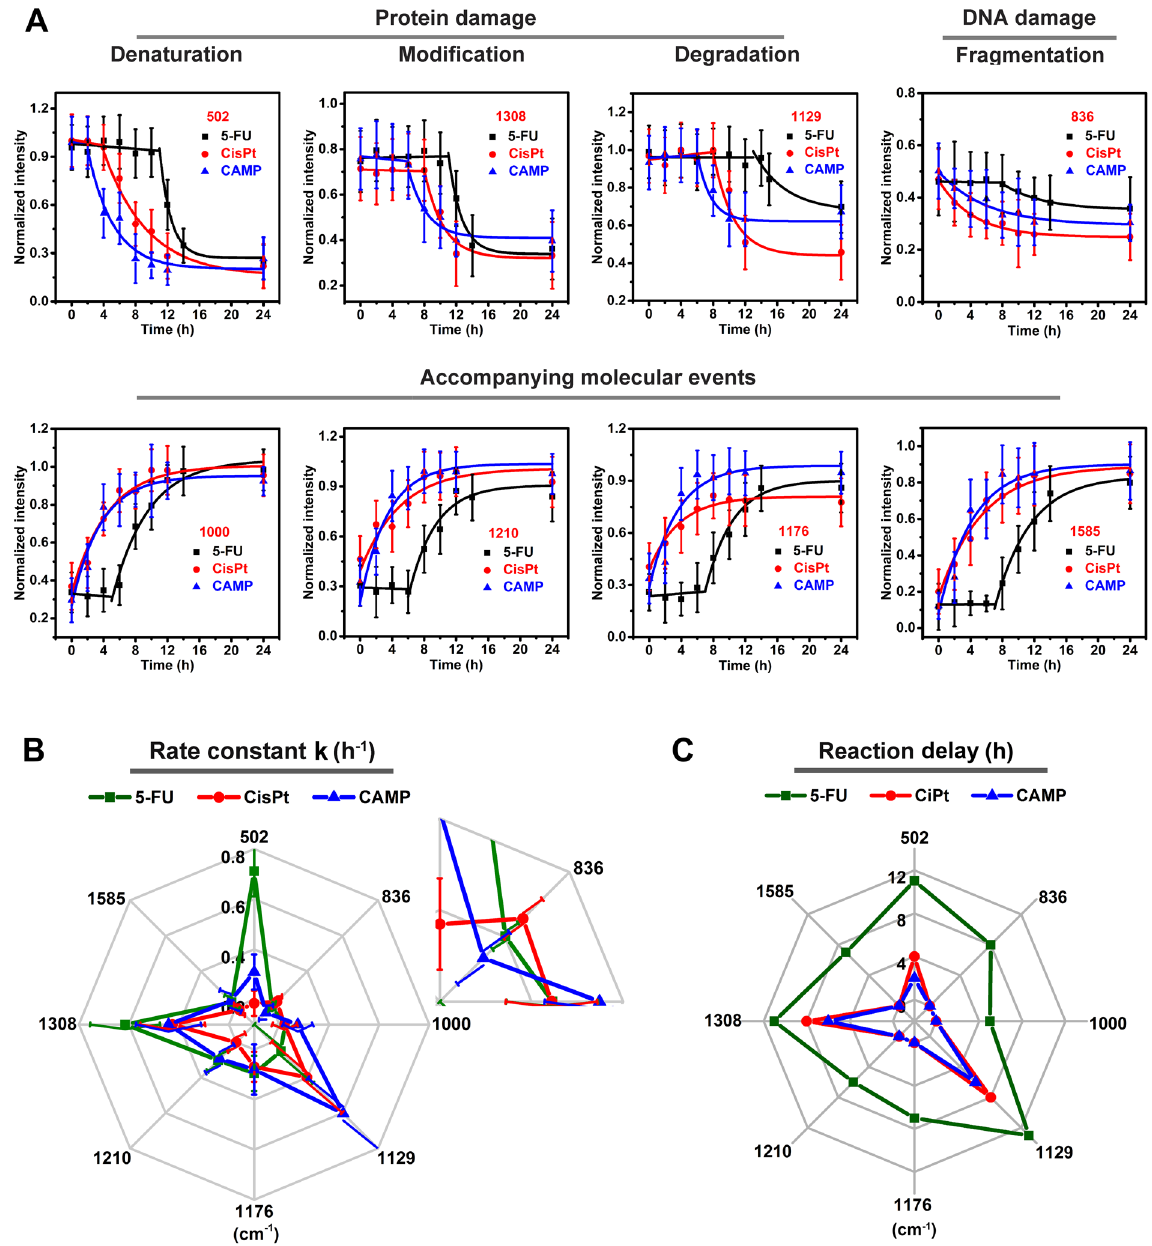
Figure 3. ( A ) Trends of the characterized Raman bands against time. Radar map of rate constant ( B ) and reaction delay ( C